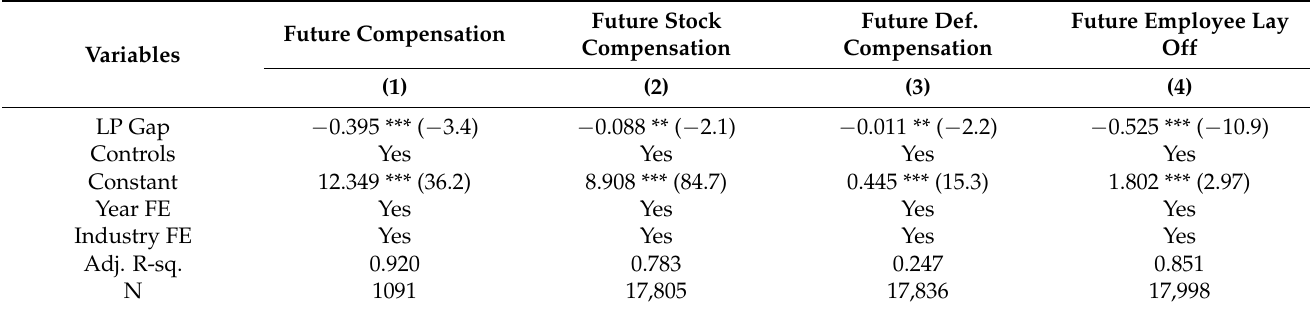
Table 7. Labor productivity gap and employee motivation. (** indicates level of significance at 95% level and *** indicates level of significance at 99% level).